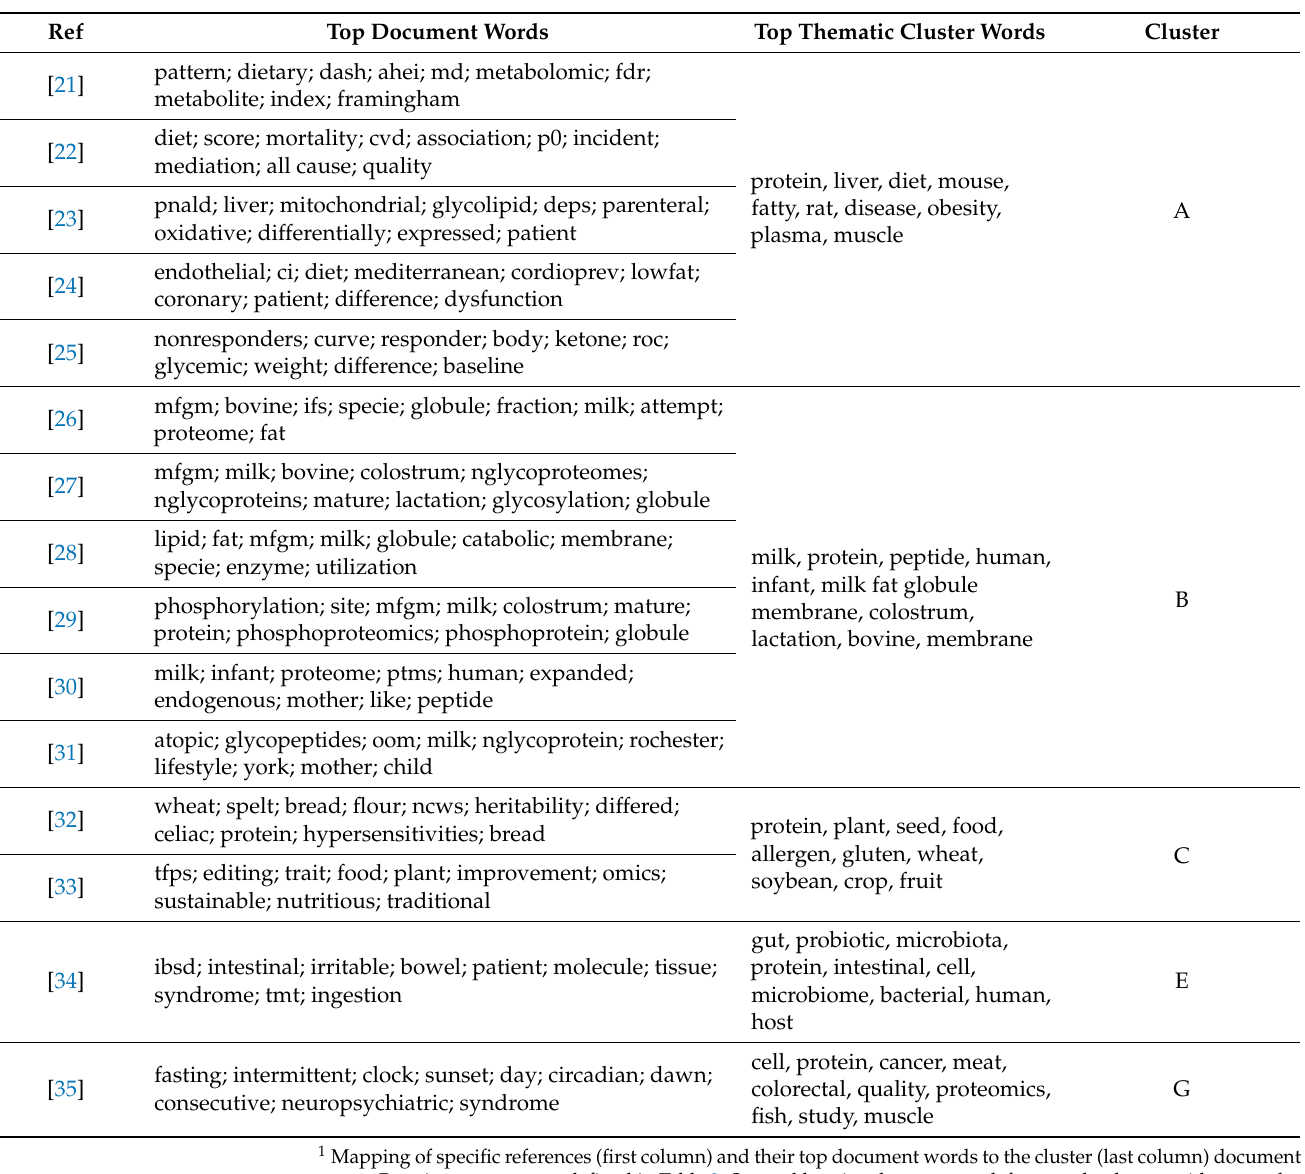
Table 5. Thematic Cluster versus Documents Words of Selected Documents 1